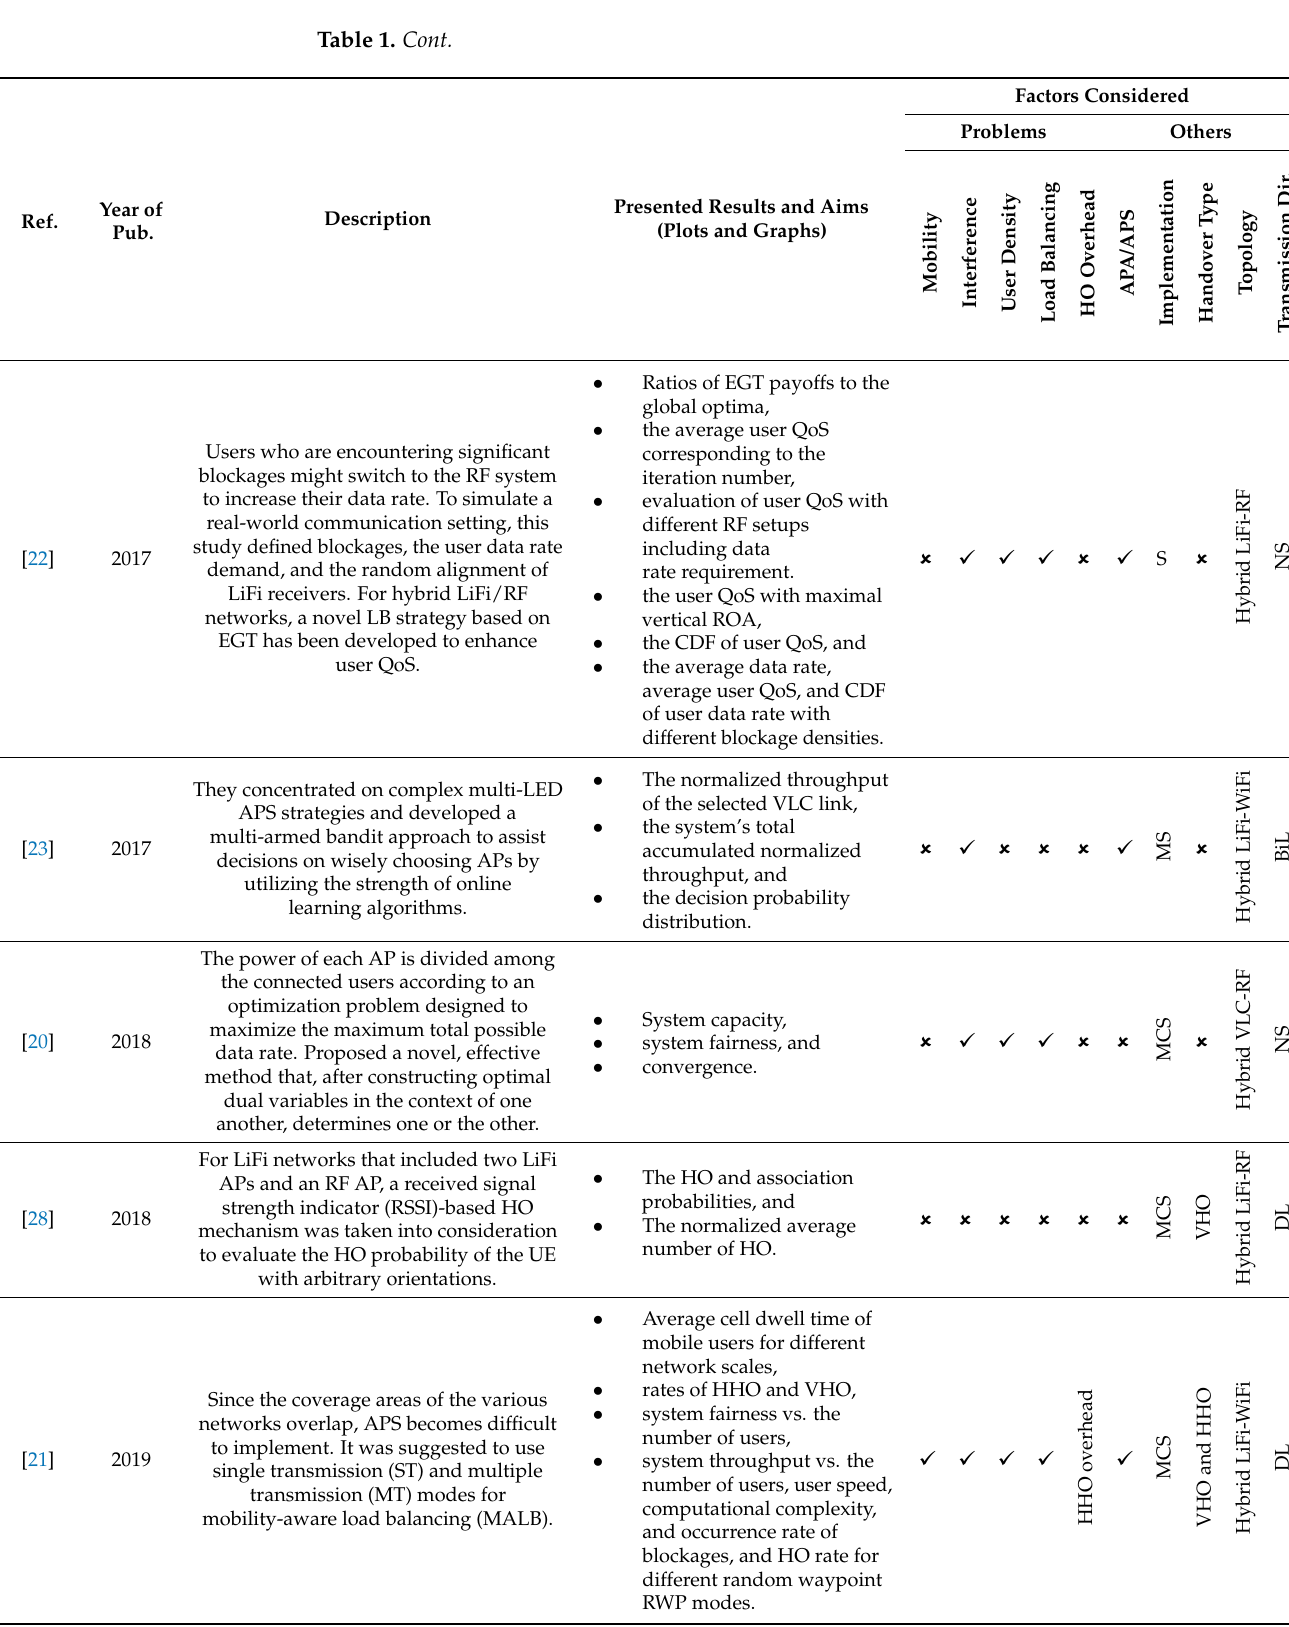
mechanism was taken into considera- tion to evaluate the HO probability of the UE with arbitrary